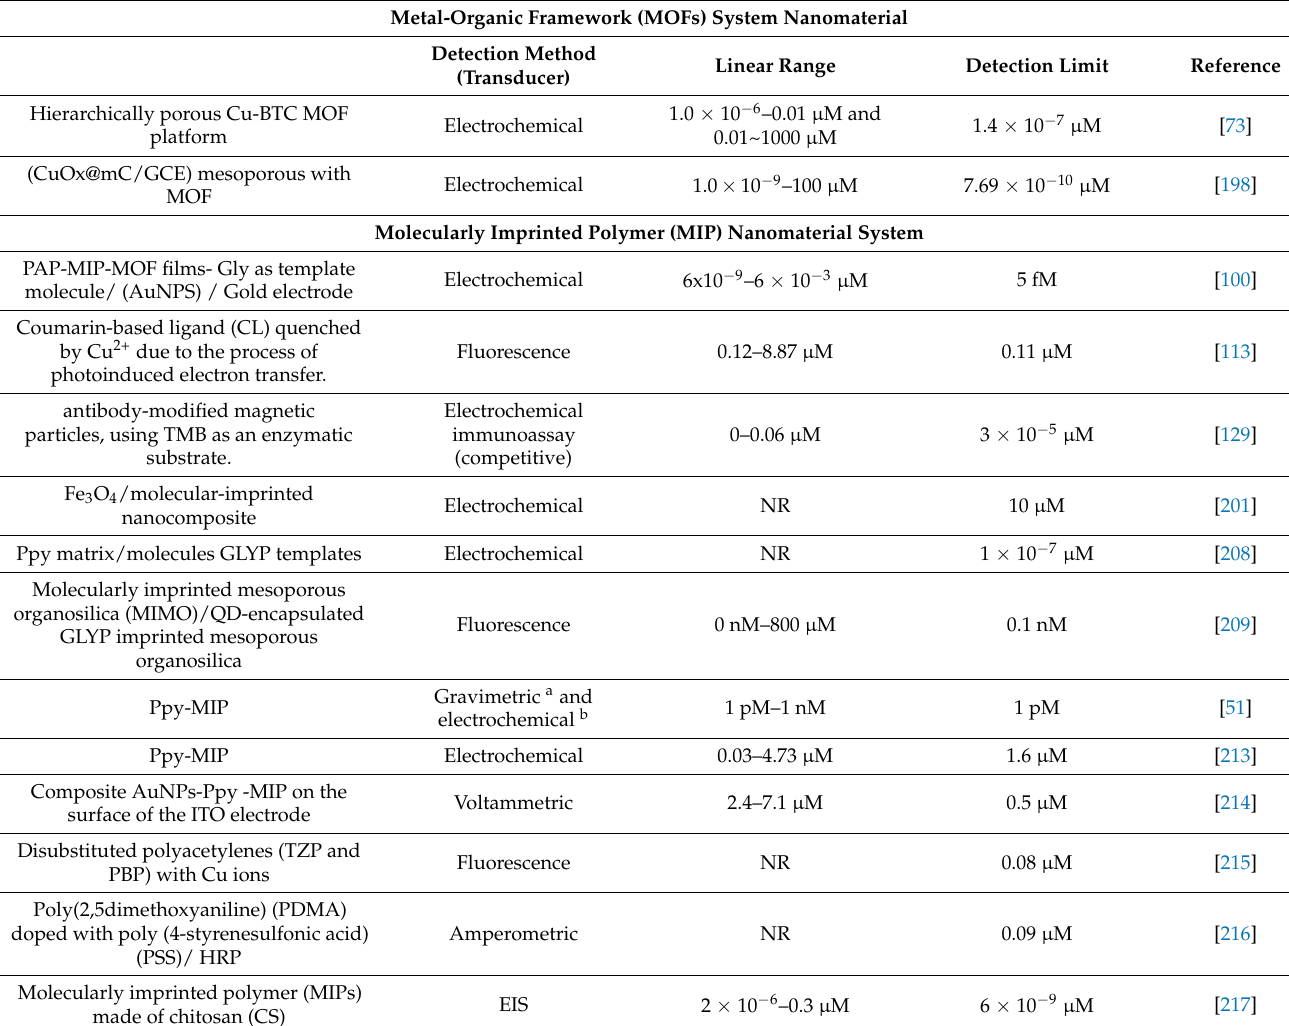
Table 4. MOF and MIPs as nanomaterial-based for GLYP